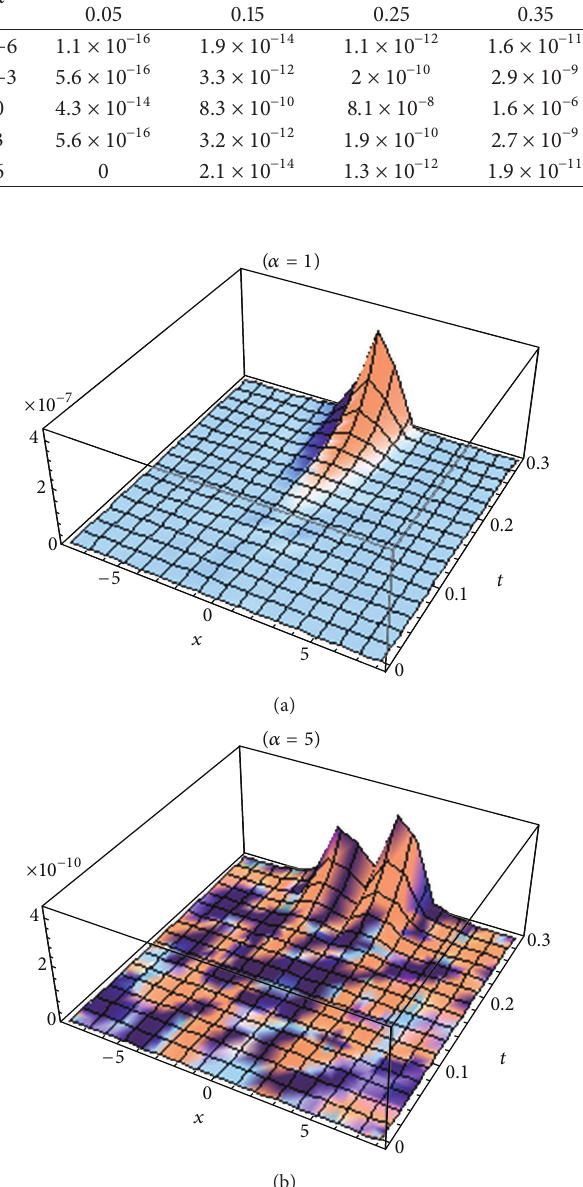
(𝑥,𝑡) are shown, app